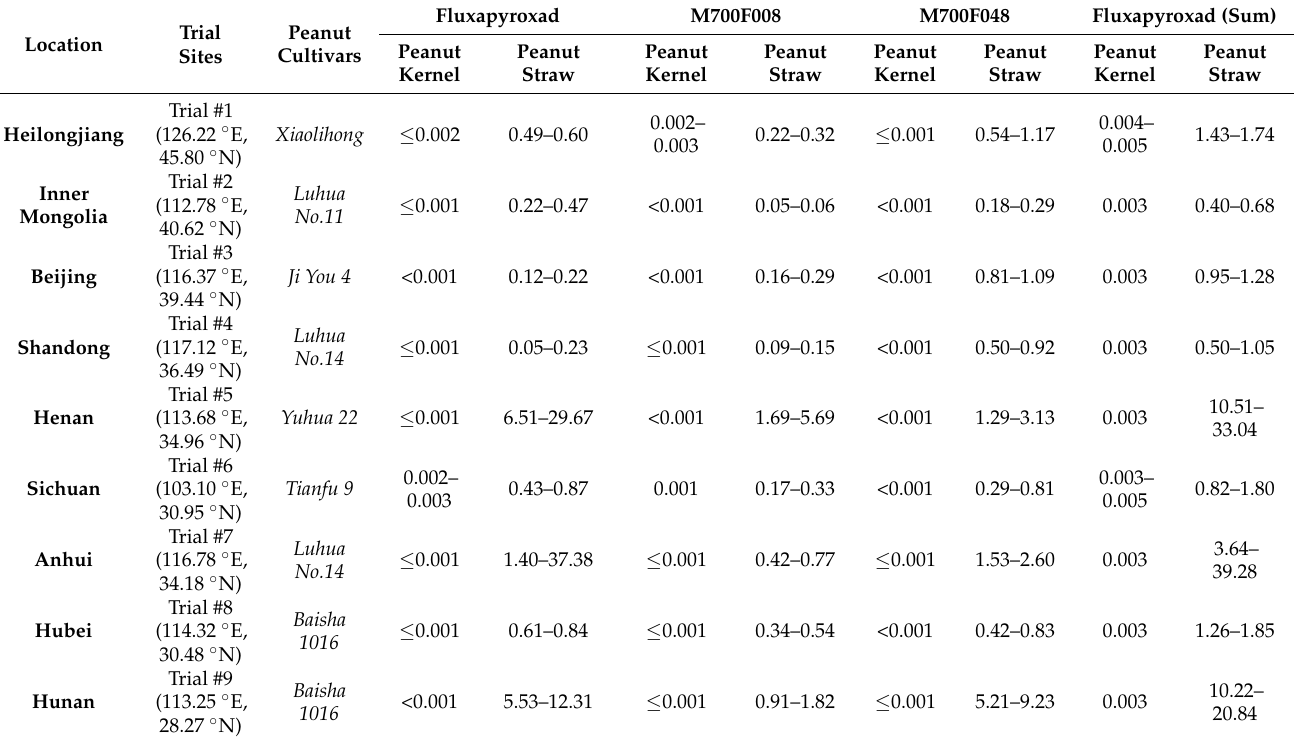
Table 2. Concentrations of fluxapyroxad and metabolites in peanut samples at 14–21 d after